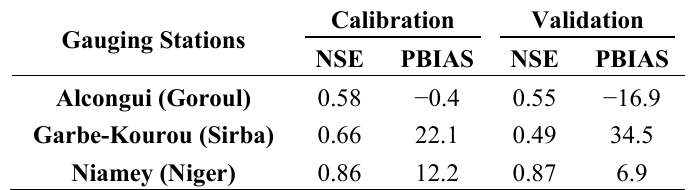
Table 2. Calibration and validation results of the eco-hydrological model SWIM